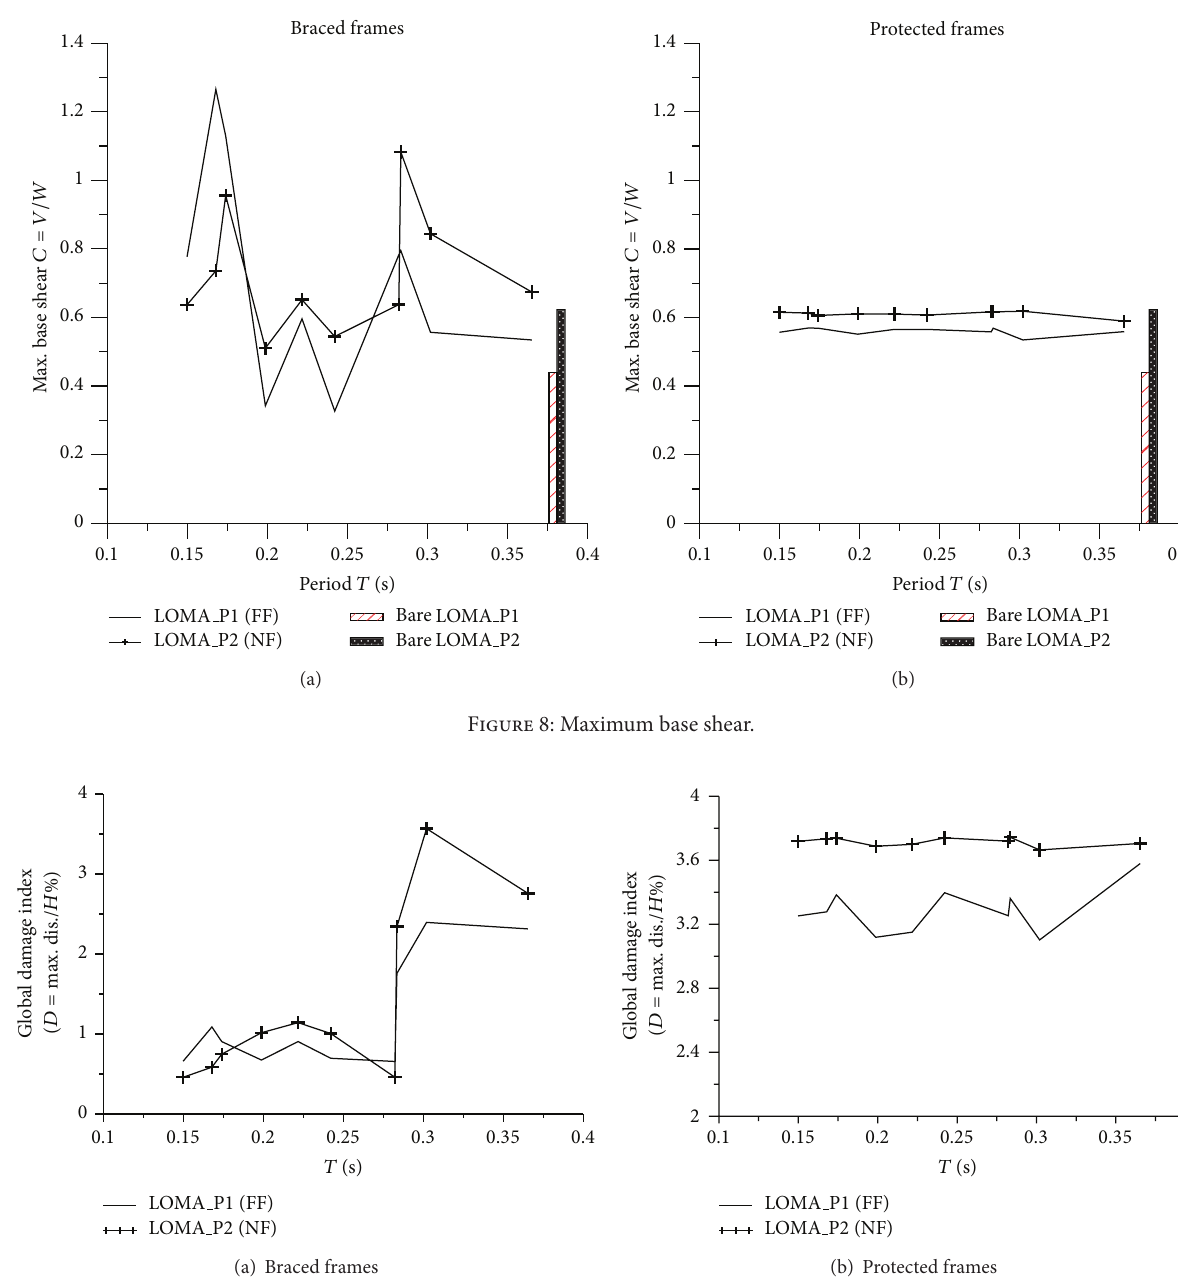
Figure 9: Global damage index for (a) braced frames and for (b) protected